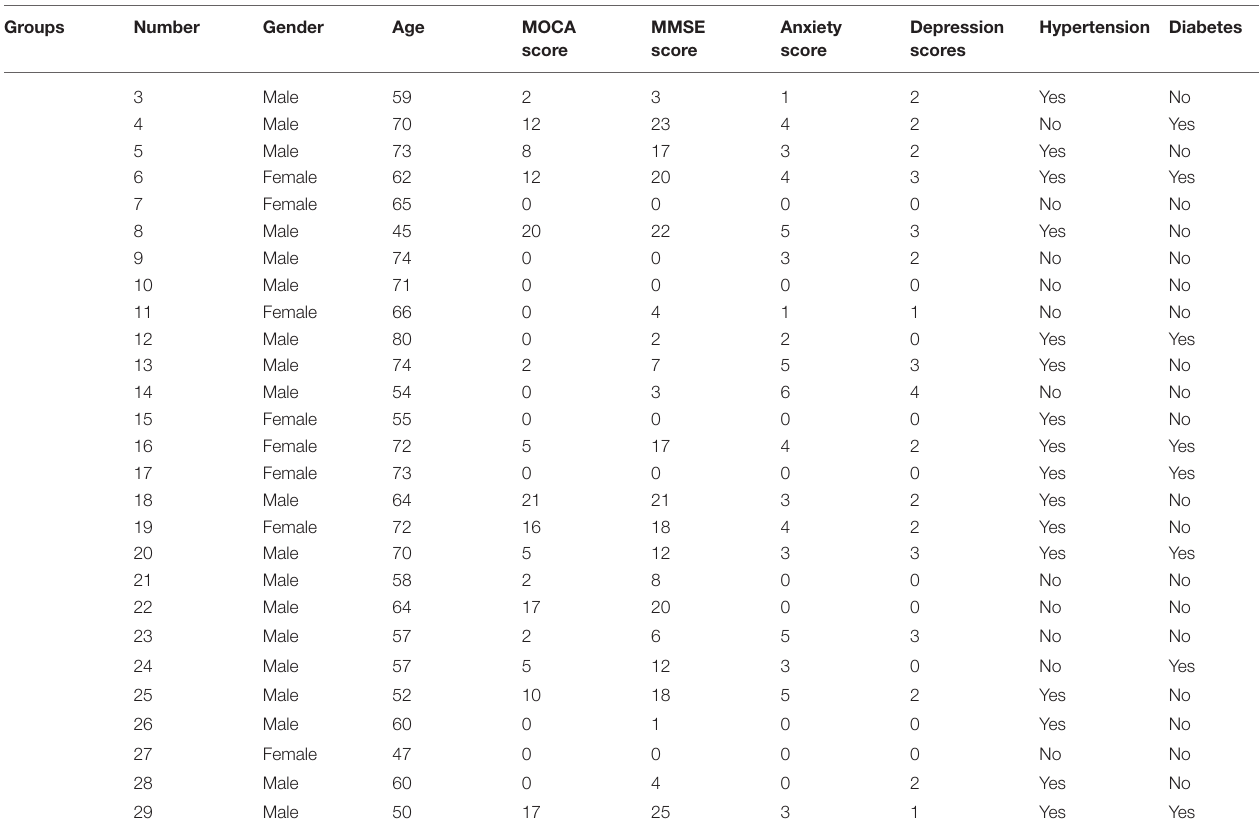
ST, stroke; PSTD, post-stroke affective disorder; PSCI, post-stroke cognitive impairment (PSCI); MOCA, Montreal Cognitive Assessment; MMSE, mini-mental state examination.